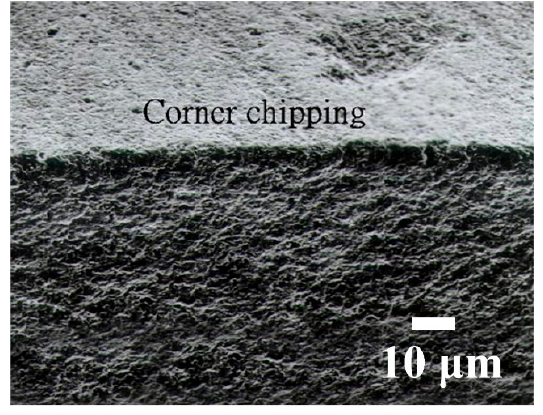
Figure 21. No corner chipping with swinging for WSM.